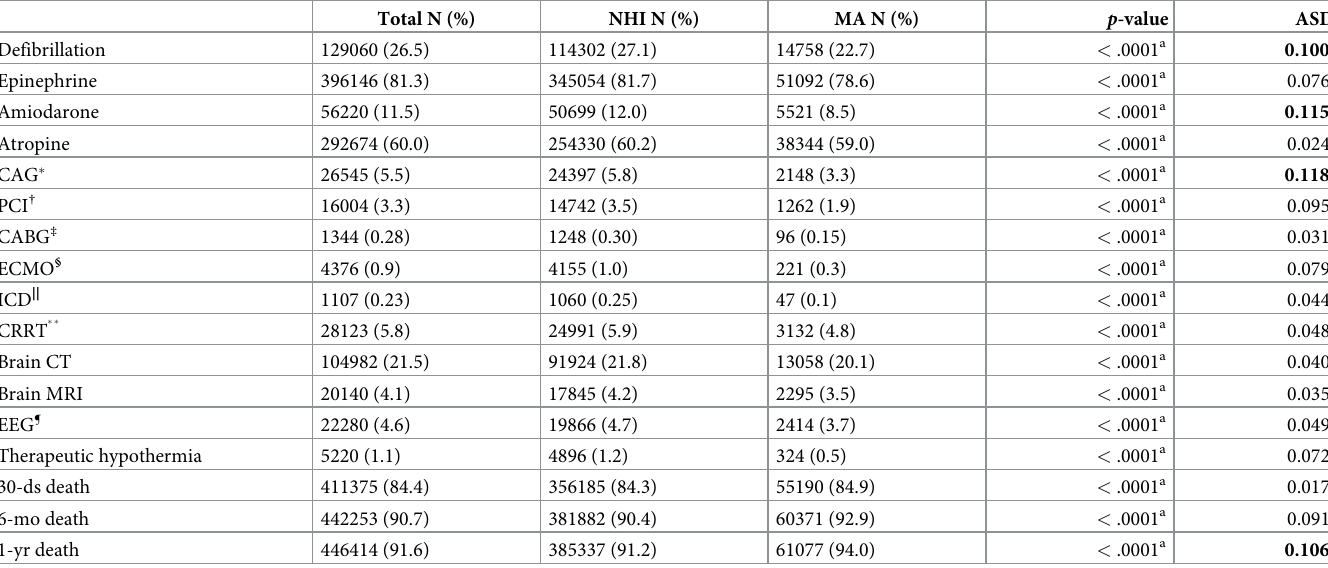
Table 3. Medications and procedures in national health insurance group and medical aid